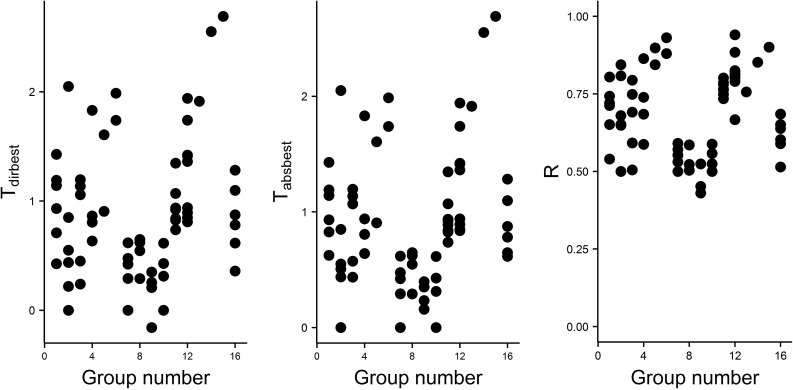
Plots of Tpos, Tneg, and R vs group number for all 68 animals.